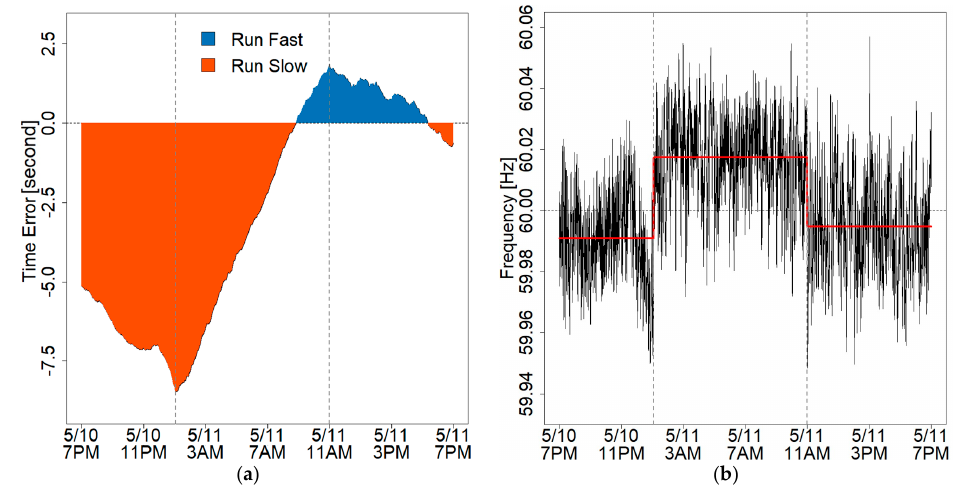
Figure 9. Illustrative example of slow time error correction (TEC) process in Eastern Interconnection (EI) system of North America: ( a ) Time error change from 10 May 2015 07:00 p.m. to 11 May 2015 07:00 p.m.; ( b ) Power system frequency change during the same period of ( a ). The grey vertical line indicates the starting/stopping point of the TEC process. The red solid line indicates the average system frequency before, during and after the TEC process.